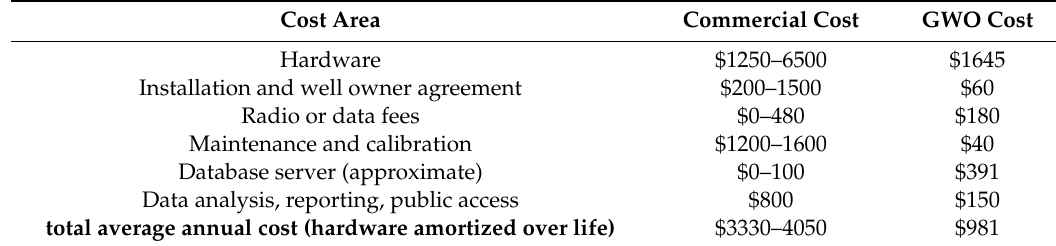
Table 2. Telemetry system costs for a commercial system and the Groundwater Observatory (GWO) (Max Stevenson, Personal Communication 2 December 2020). Values are based on a lifespan of commercial system of 5–20 years, and a GWO lifespan of 10 years. Average annual costs are provided in the last row of the